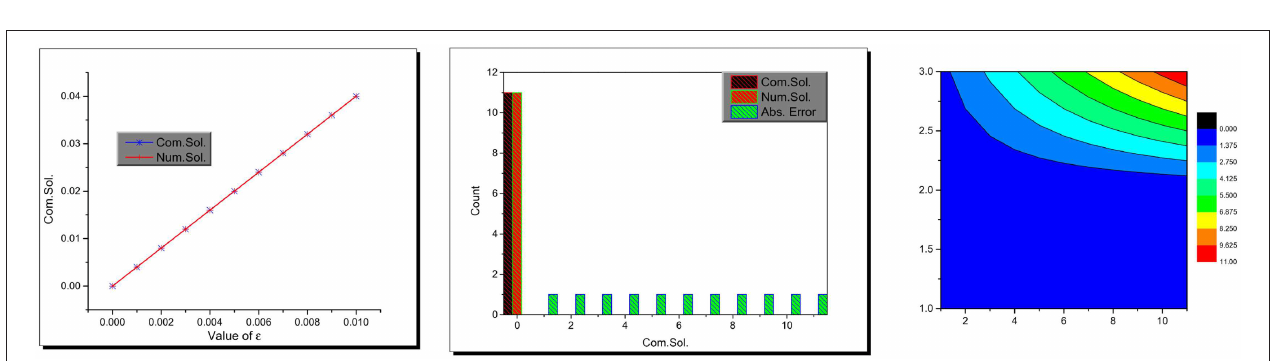
Frontiers in Physics |